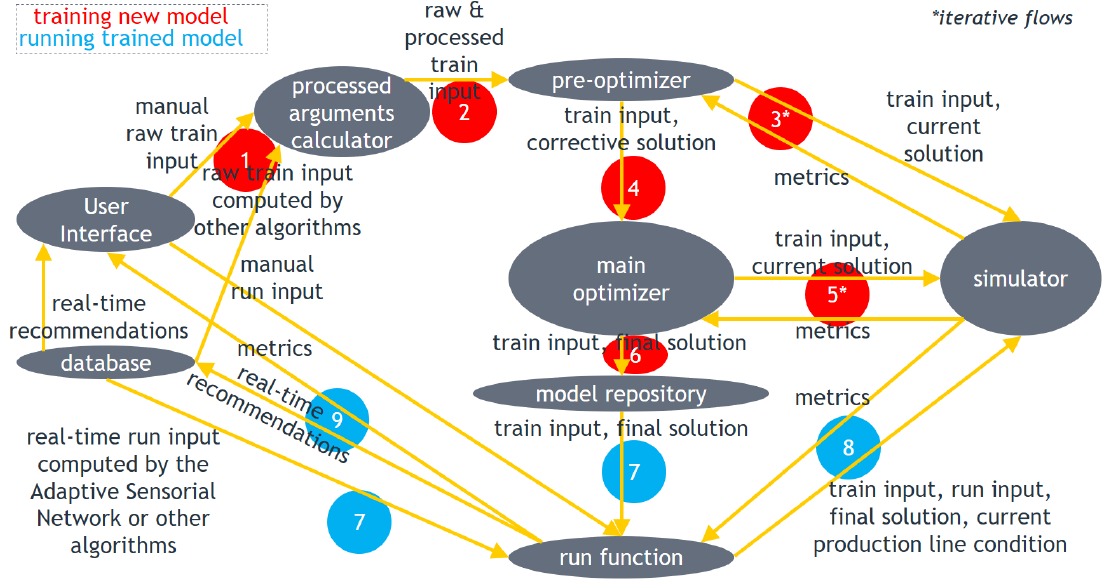
Figure 1. DSF Core architecture. The numbers indicate the sequence of information